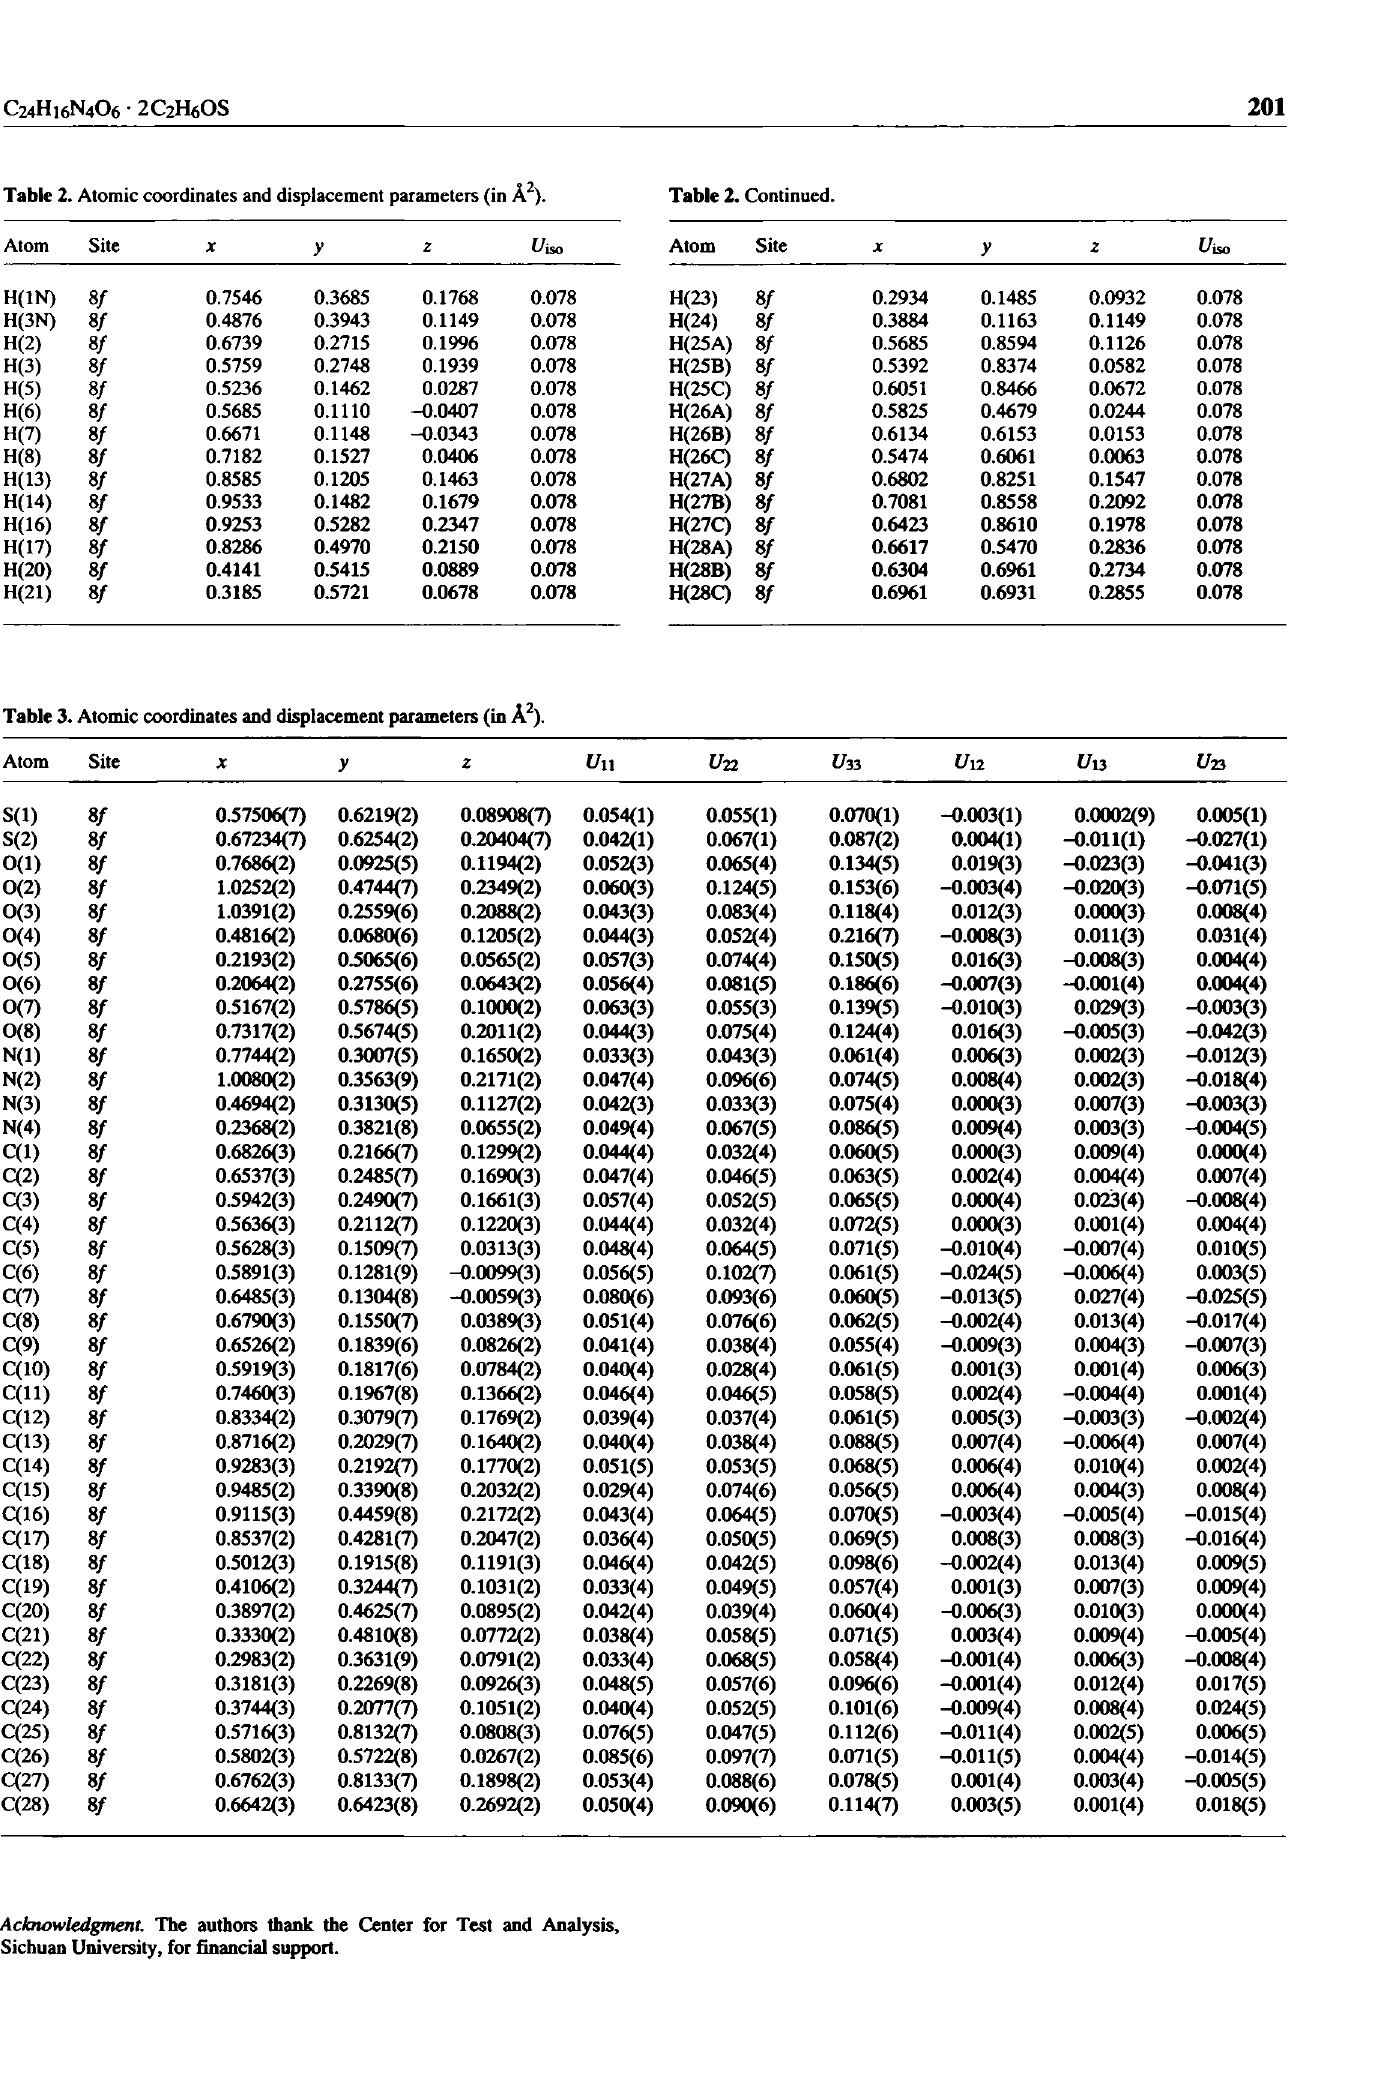
Table 3. Atomic coordinates and displacement parameters (in A 2